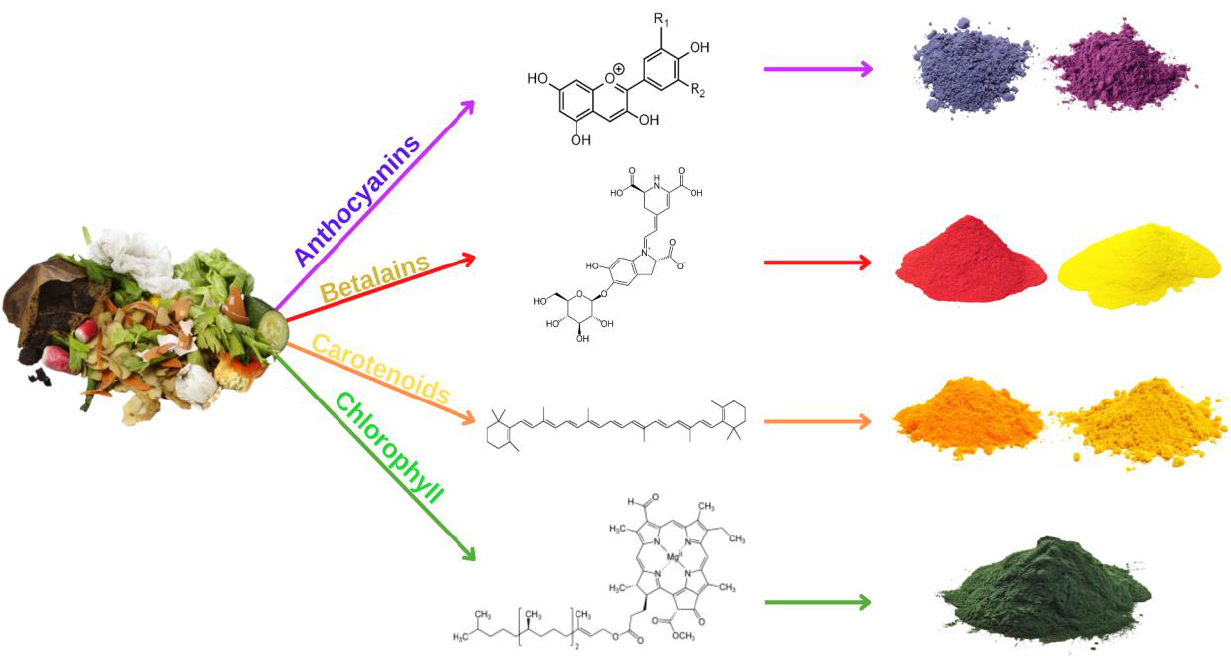
Figure 1. Natural source of pigments.